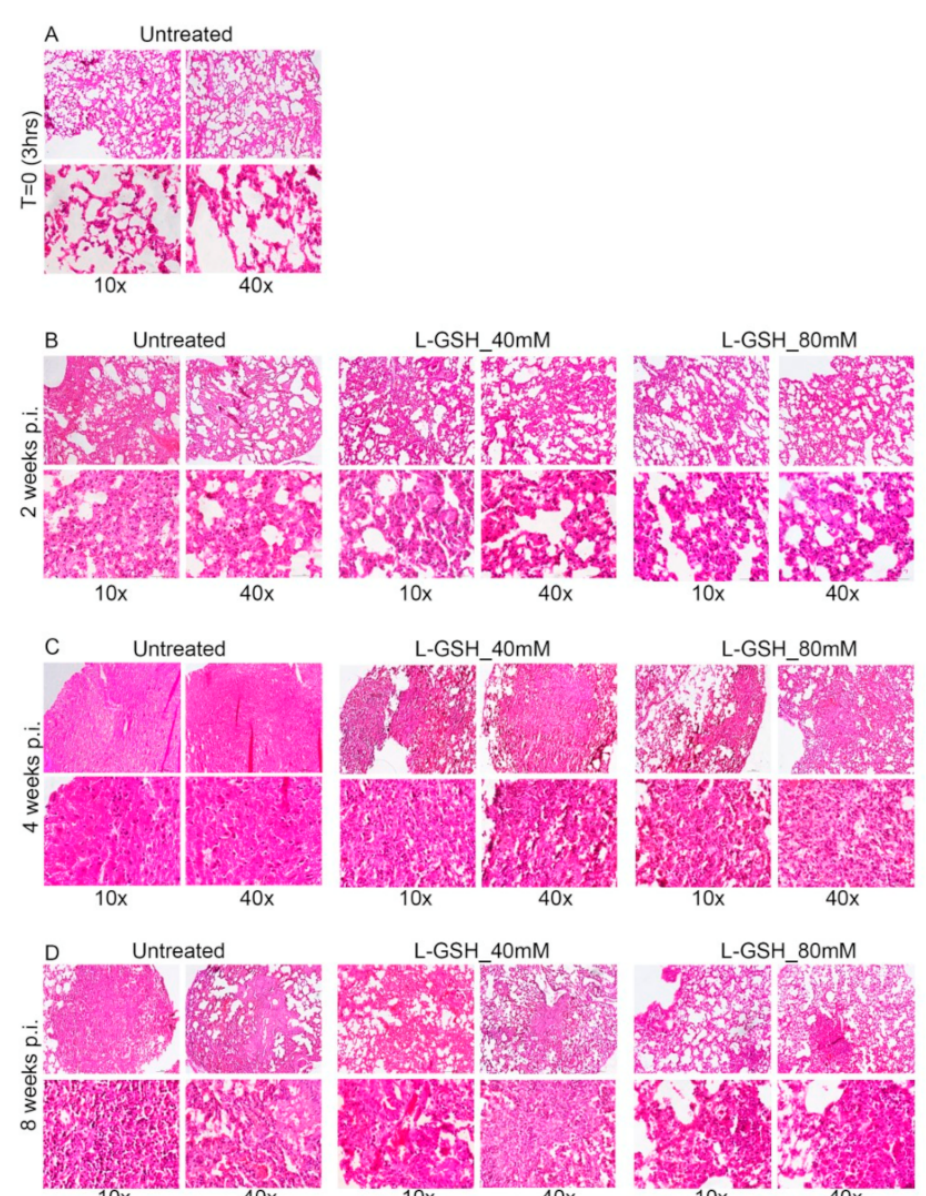
Figure A1. Additional images of the lung granuloma histology in M. tb -infected untreated and L-GSH-treated mice (40 mM and 80 mM L-GSH treatment). The images are of mice euthanized at 3 h post-infection ( A ), 2 weeks post-infection ( B ), 4 weeks post-infection ( C ), and 8 weeks post- infection ( D ). The lung sections were stained with hematoxylin and eosin to visualize the presence of granulomas, inflammation, cell infiltration, and cellular aggregates with and without L-GSH treatment under bright field microscopy. The images are magnified at 10 × and 40 ×